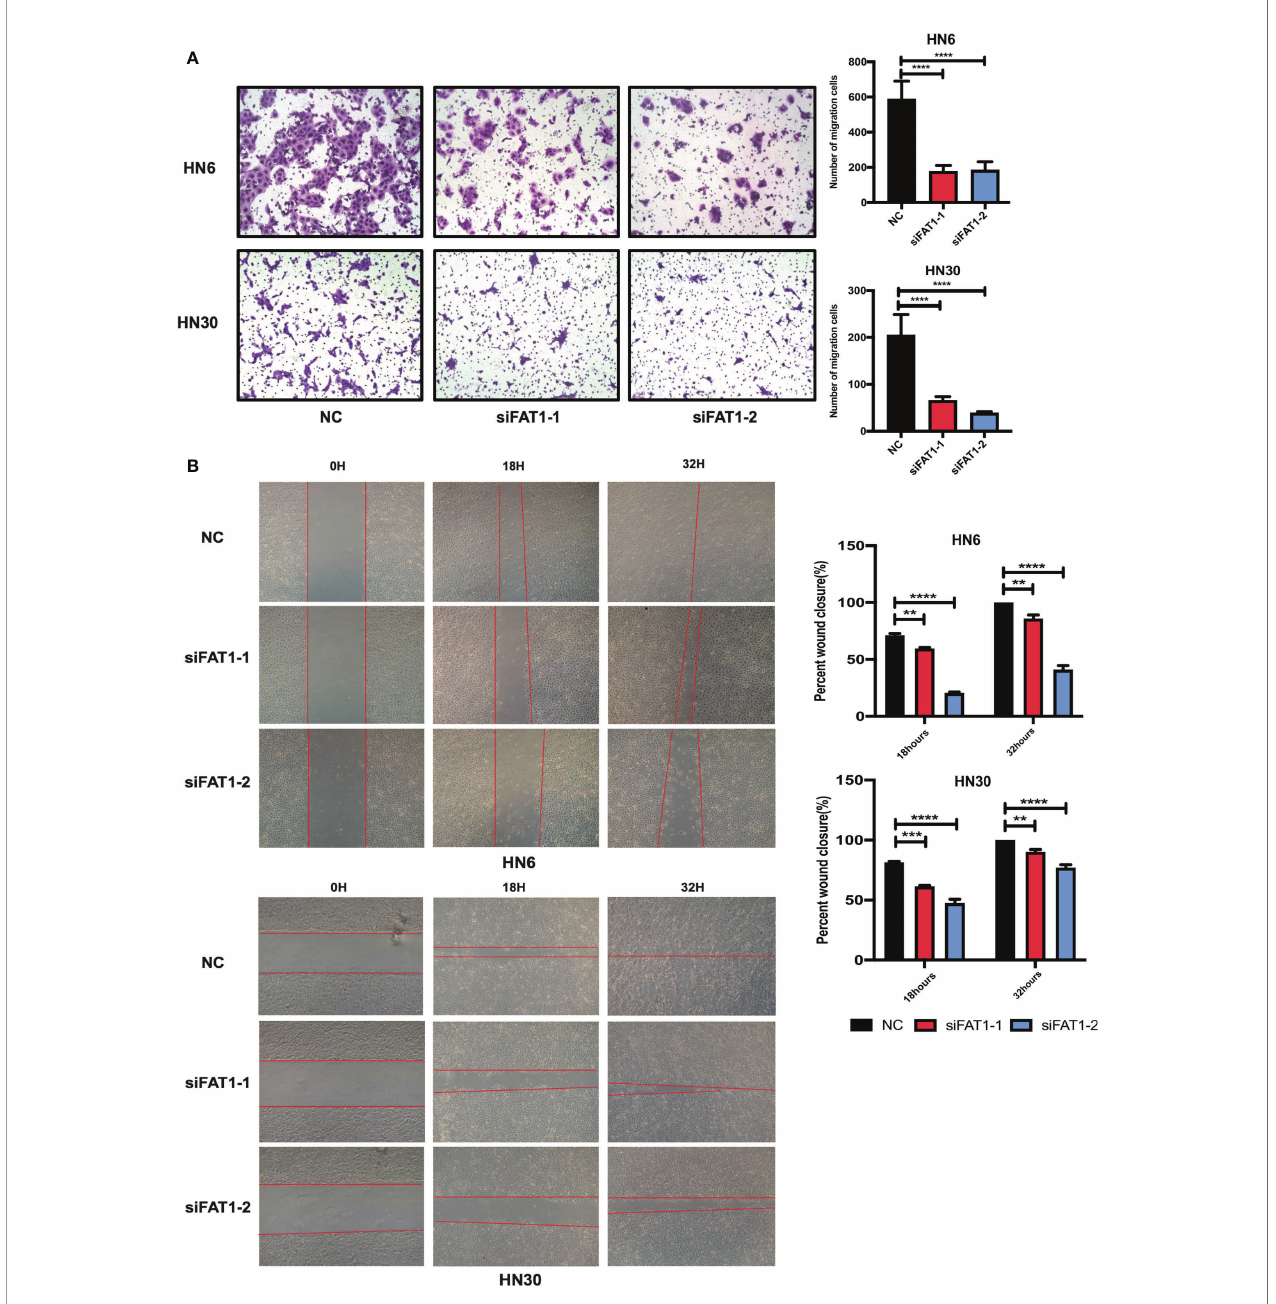
FIGURE 5 | Downregulation of FAT1 impairs migration ability of OSCC. Knockdown by siFAT1-1 and siFAT1-2 inhibited HN6 and HN30 cells migration via transwell chambers without Matrigel (A) and wound healing migration assays (B) . **P < 0.01; ***P < 0.001; ****P <